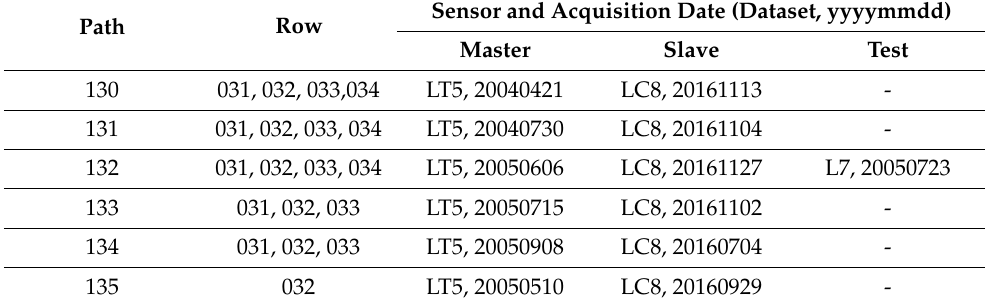
Table 1. Landsat scenes used to estimate sand dune displacement. Sensor and Acquisition Date (Dataset, yyyymmdd) Path Row Master Slave Test 130 031, 032, 033,034 LT5, 20040421